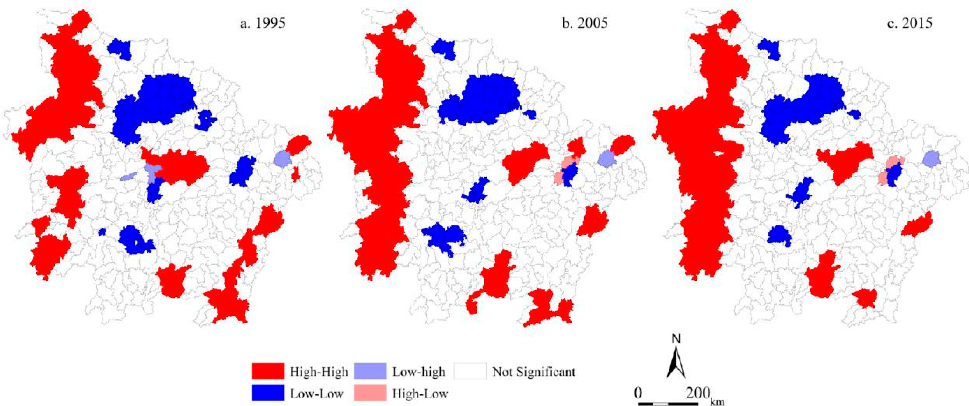
Figure 3. LISA clustering of ecosystem services supply capacity in the MRYRUA from 1995 to 2015. ( a ) LISA clustering of ecosystem services supply capacity in 1995. ( b ) LISA clustering of ecosystem services supply capacity in 2005. ( c ) LISA clustering of ecosystem services supply capacity in 2015.